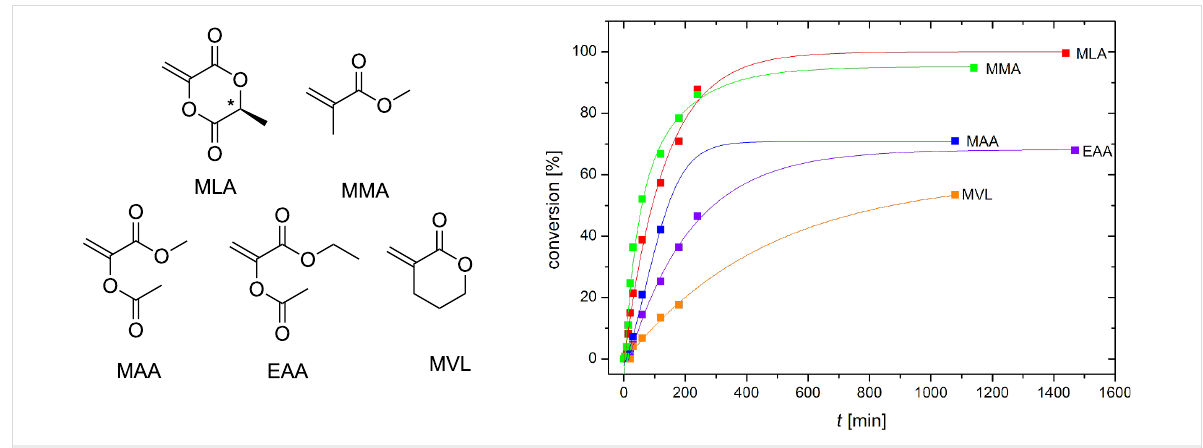
Figure 1: Structures of used monomers and the time-conversion plot of the corresponding free-radical polymerization reactions (80 wt % DMF, 1 mol % AIBN, 70